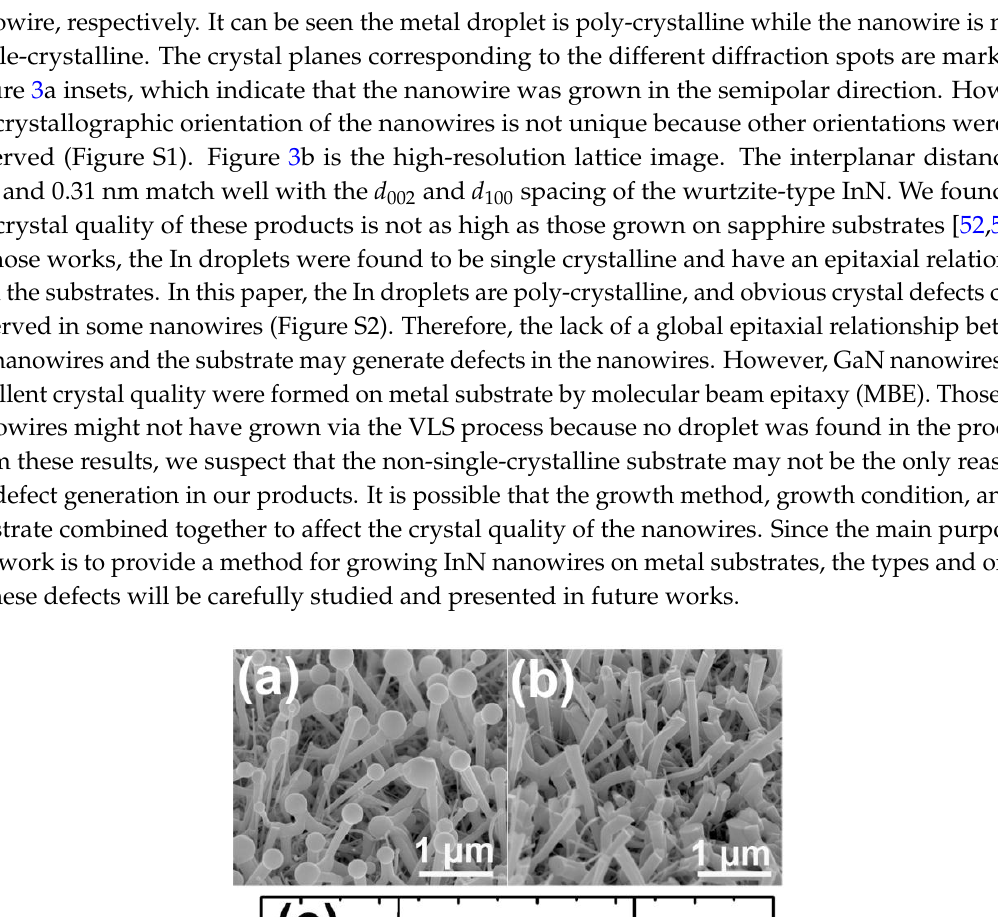
Figure 3. Structural characterization of the InN nanowires. ( a ) Transmission electron microscope (TEM) and ( b ) high-resolution TEM images of a nanowire. The insets in ( a ) are the selected area electron diffraction (SAED) patterns of the In droplet and the nanowire, respectively marked as 1 and 2 of the product. ( c ) Energy-dispersive X-ray spectroscopy (EDXS) spectra of the In droplet (upper line) and the InN nanowire (bottom line). ( d1 ) The high-angle annular dark-field (HAADF) image collected from the box labeled area in ( a) . ( d2 – 4 ) The EDXS elemental mapping of the box labeled area of the nanowire.